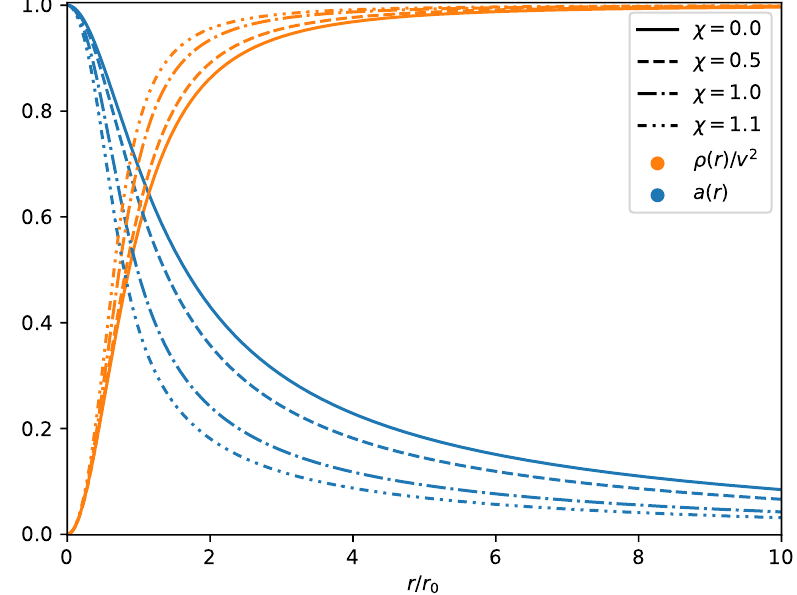
Figure 6 . Matter fields of the non-singular self-gravitating Abrikosov vortex of vorticity N = 1 in asymptotically AdS 3 space-time of radius ‘ = 1 for increasing values of the “strength of gravity” χ = 16 πGv 2 .